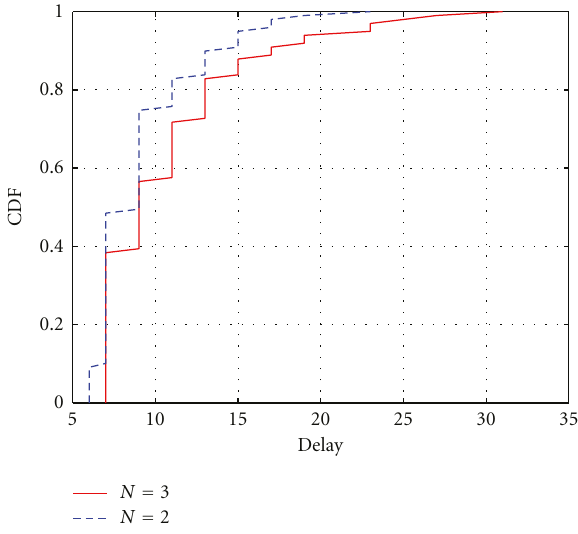
Figure 16: CDF of learning delay when the system state is partially